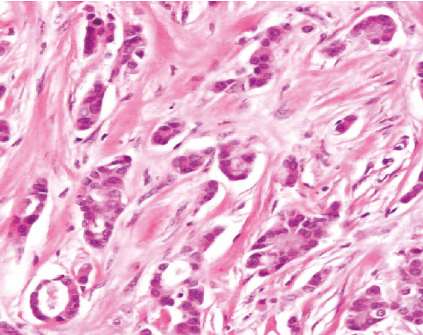
Figure 1: Histologic image of infiltrative carcinoma with subacute mastitis. G × 100, HE (Collection of the Department of Pathology, University Teaching Hospital of Lom´e)